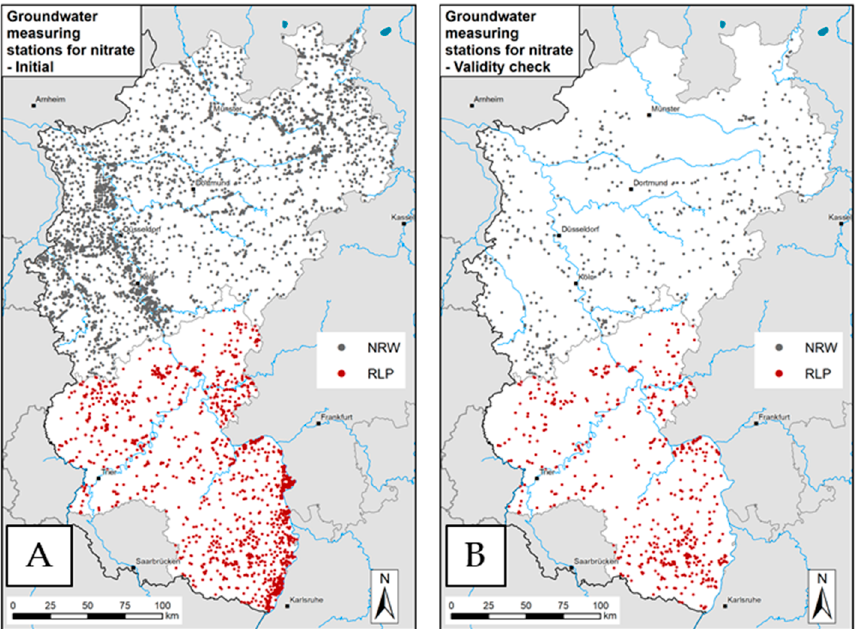
Figure 5. Initially available monitoring sites from state measuring networks in North Rhine-Westphalia (NRW) and Rhineland-Palatinate (RLP) ( A ) and preselected monitoring points included in the plausibility check ( B ).